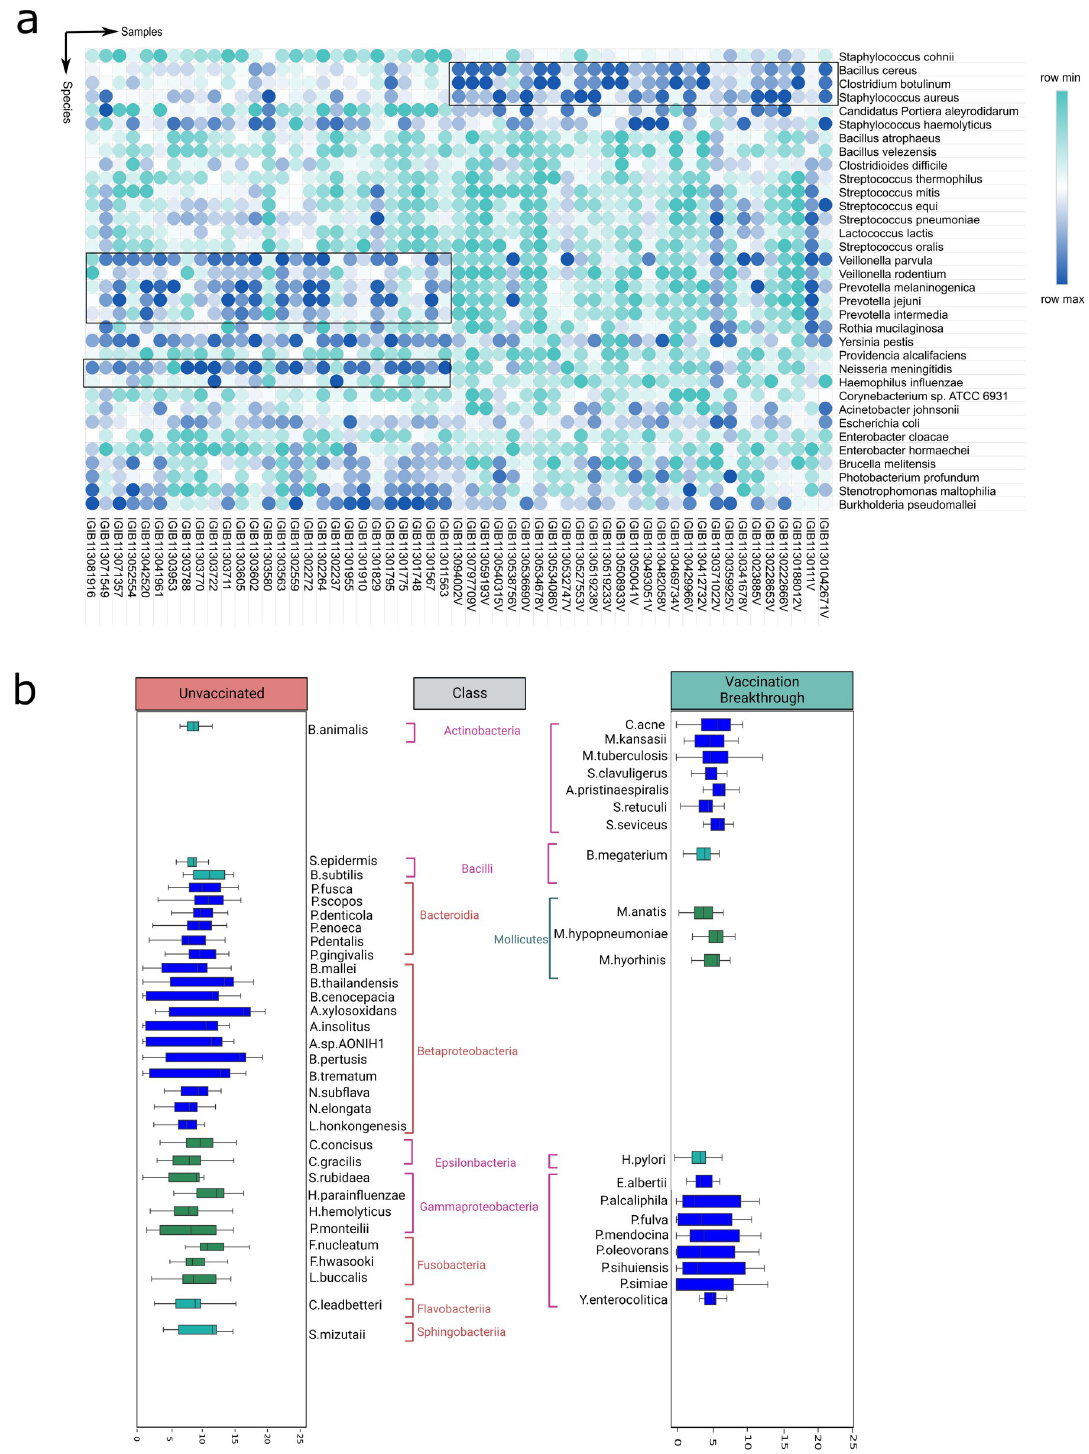
Fig 4. Unique and shared microbial species between the vaccination breakthrough and the unvaccinated patients. (a) Heatmap highlights the sample level dynamics of the common microbial species between the two sub-groups. The sub-clustering of the microbial species has been further highlighted with an encircled box. (b) The microbial class of the differentially abundant unique microbes between the vaccination breakthrough and unvaccinated patients highlight the possible functional dynamics with differential abundance of the commensal and opportunistic